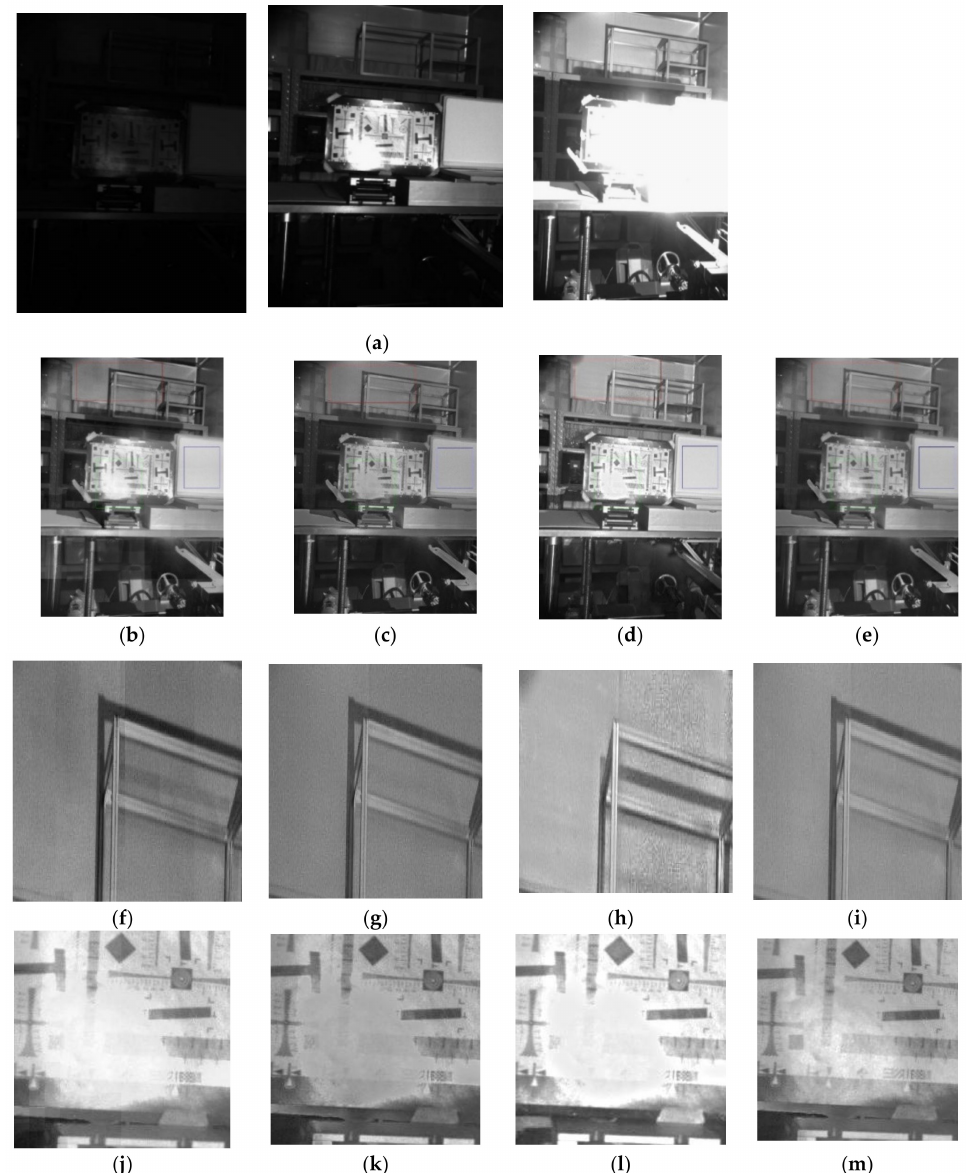
Figure 6. The comparison of different methods. ( a ) Source image sequence. ( b ) The fusion image of [16]. ( c ) The fusion image of [29]. ( d ) The fusion image of [15]. ( e ) The fusion image of our method. ( f ) Local image of method [16]. ( g ) Local image of method [29]. ( h ) Local image of method [15]. ( i ) Local image of our method. ( j ) Local image of method [16]. ( k ) Local image of method [29]. ( l ) Local image of method [15]. ( m ) Local image of our